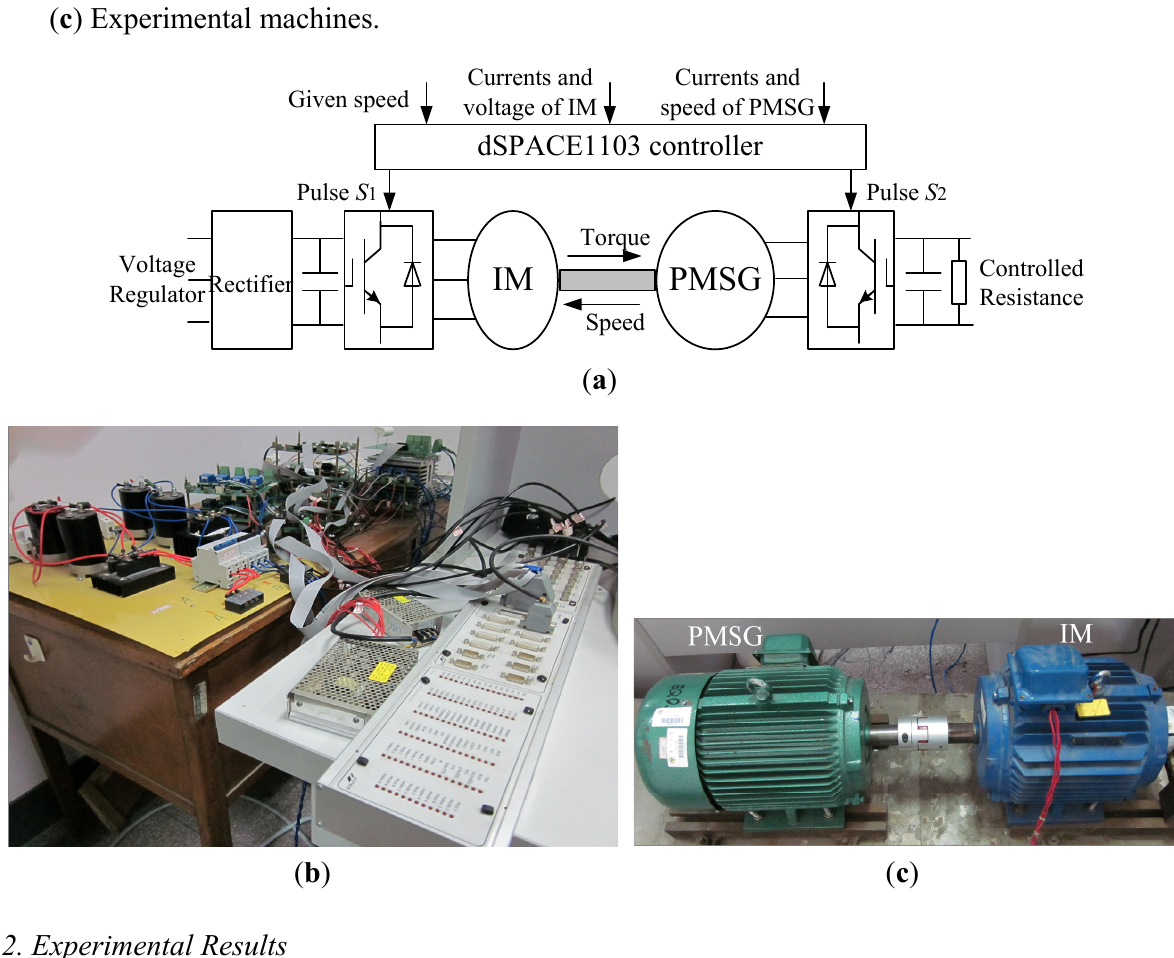
Figure 10. Experimental platform ( a ) Configuration; ( b ) Control platform; ( c ) Experimental machines. Currents and PMSGCurrents and Given speed speed of voltage of dSPACE1103 controller SpeedPulse S 1 Pulse S 2 Torque RectifierVoltage IM PMSG Regulator